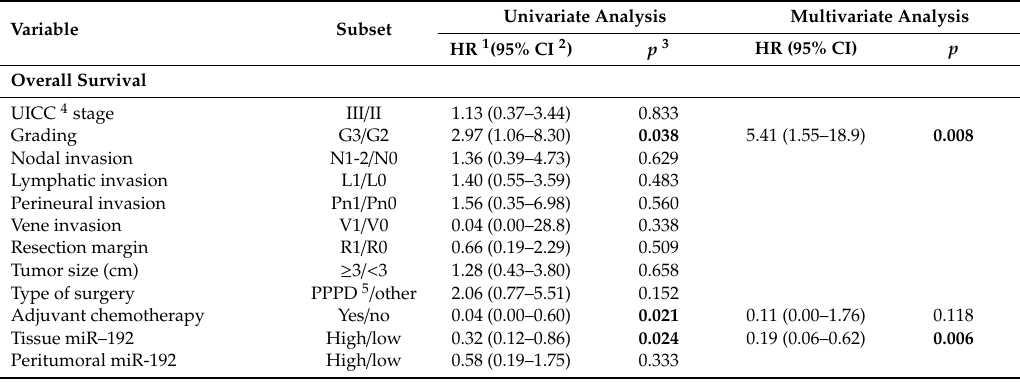
Table 3. Univariate and multivariate survival analysis of curatively resected PDAC patients in regard to overall survival and recurrence-free survival.